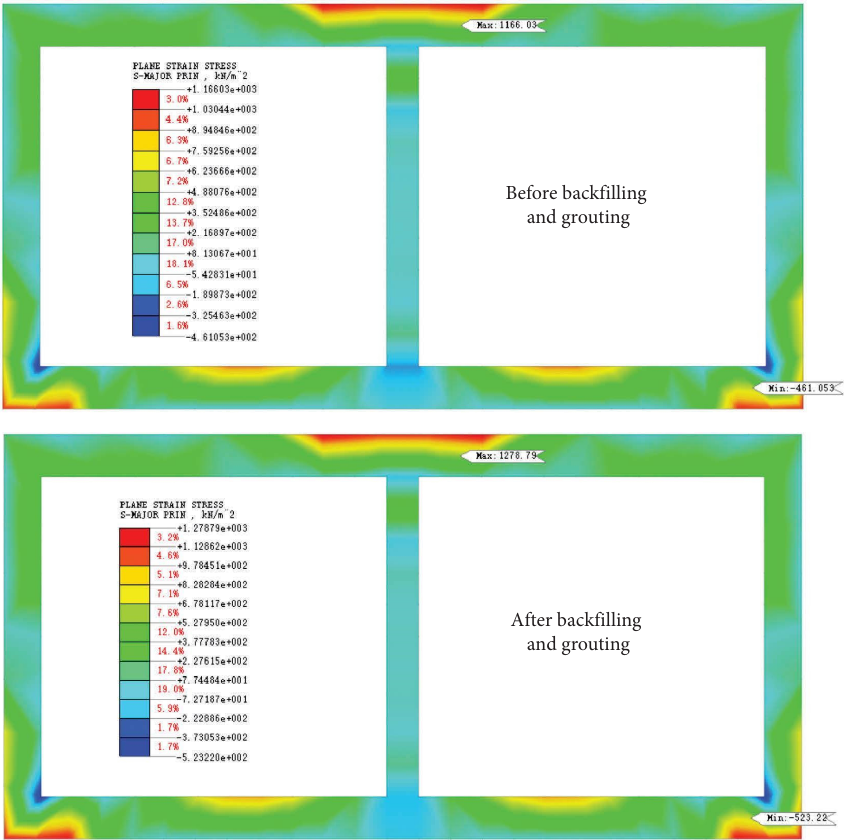
Figure 24: Stress changes of utility tunnel before and after backfll